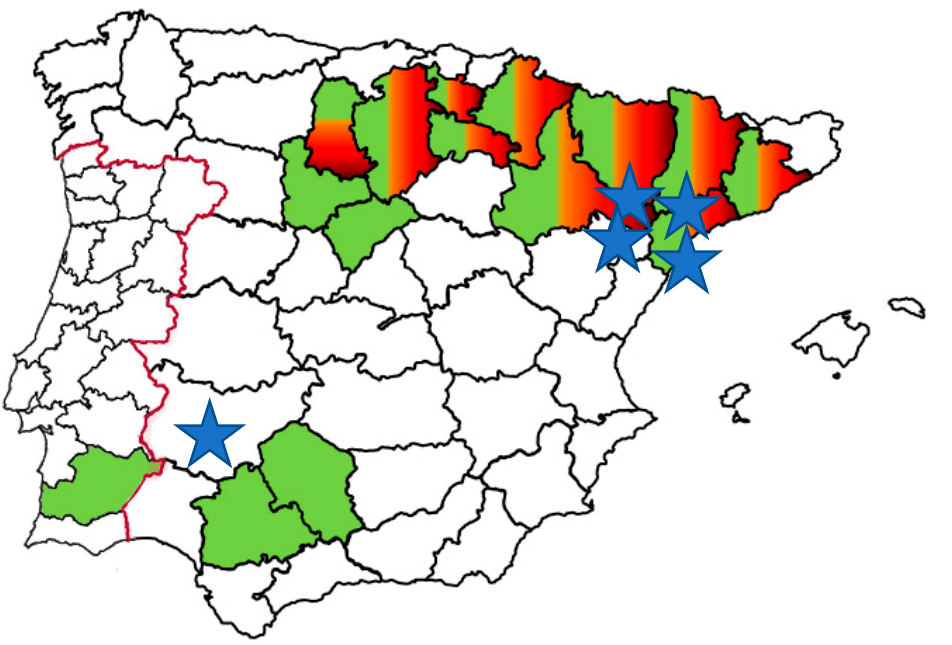
Figure 3. Map of resistance occurrence (provinces) for Papaver rhoeas (painted) and Amaranthus palmeri (stars). For P. rhoeas , green indicates resistance to ALS inhibitors, red to 2,4-D (none), and green to red indicates multiple-herbicide resistance to both. Red line denotes border between Spain and Portugal.